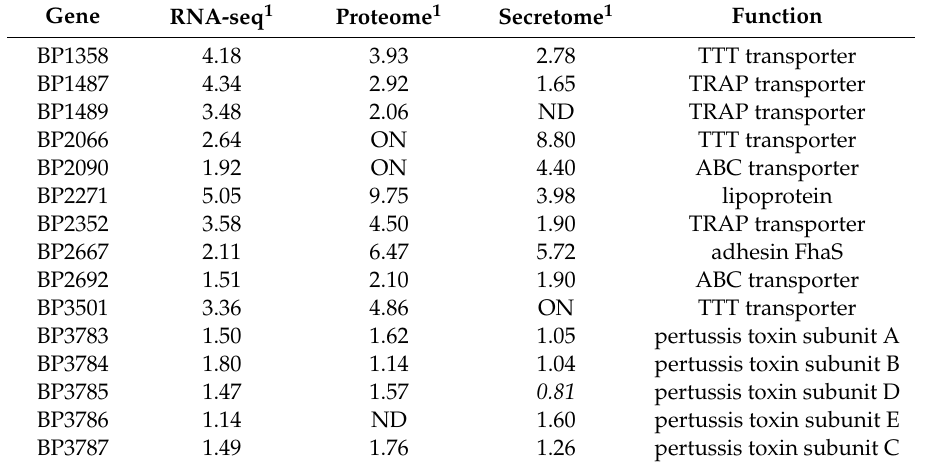
Table 1. List of genes showing consistently increased RNA and protein abundance in the hfq mutant. Gene RNA-seq 1 Proteome 1